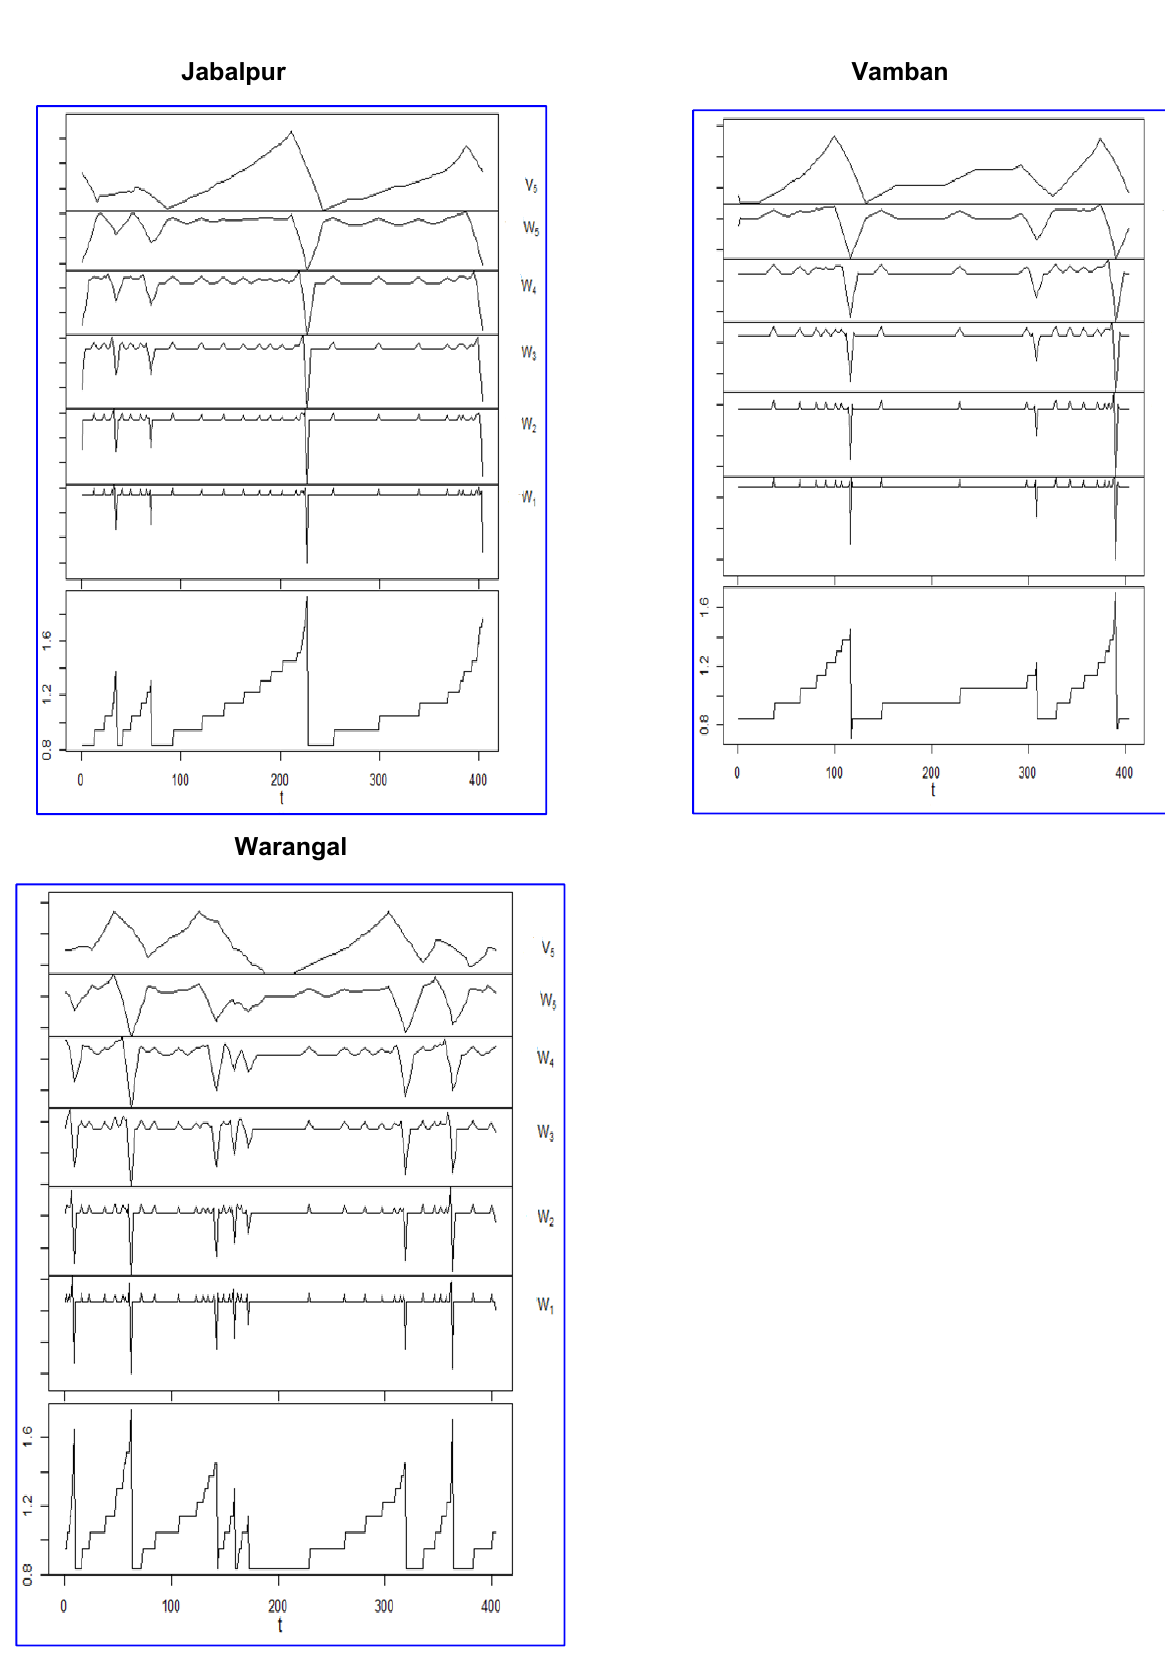
Figure 5. Maximal overlap discrete wavelet transform (MODWT)of spider occurrence across the location.